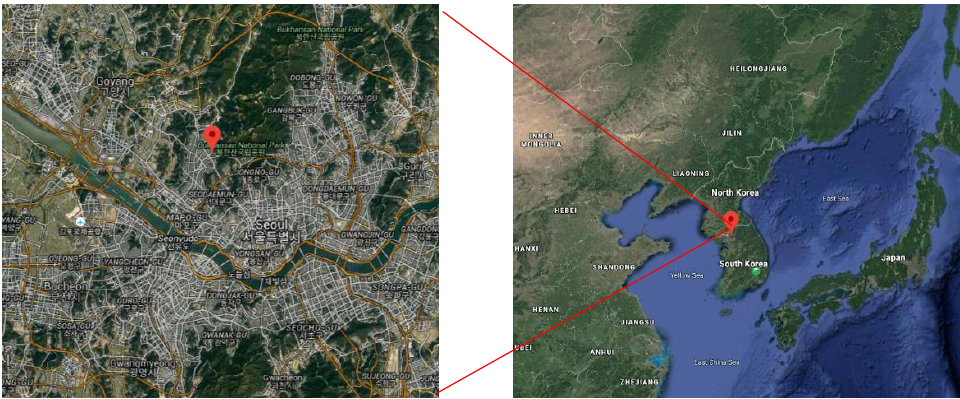
Figure 1. The location of the sampling site is flagged with a red point in the map.